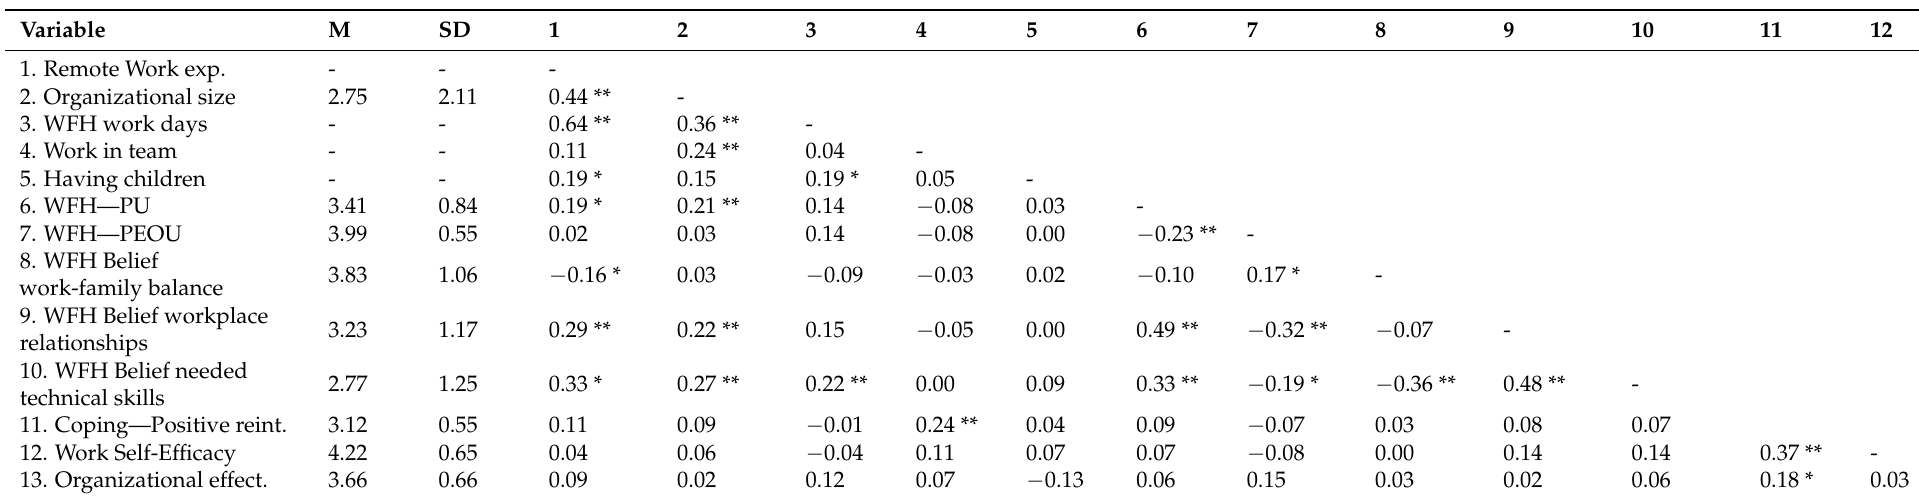
Table 2. Means, Standard Deviations and Correlations among study focal